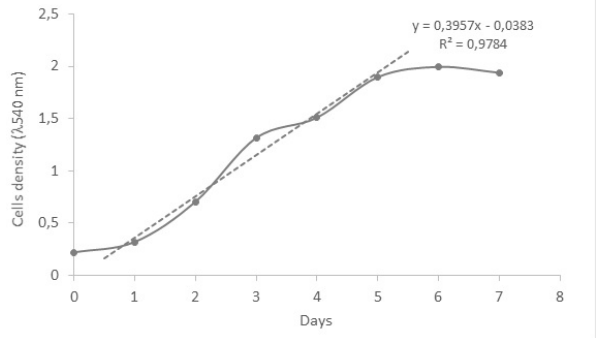
Figure 1: The growth curve of Chlorella vulgaris in BG-11 medium. The curve showed a doubling time for cell growth on 3.7